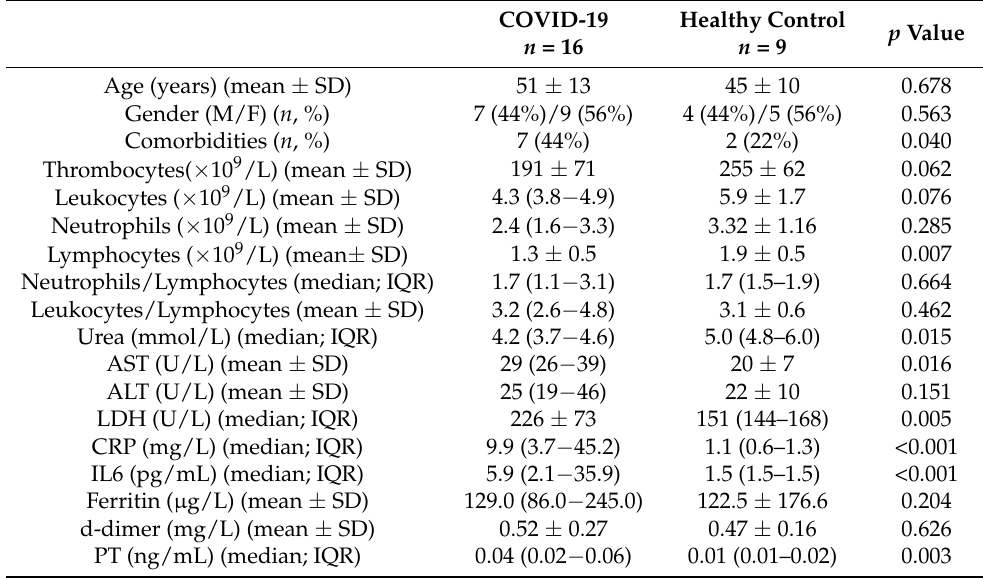
Table 1. Baseline characteristics of COVID-19 patients and healthy